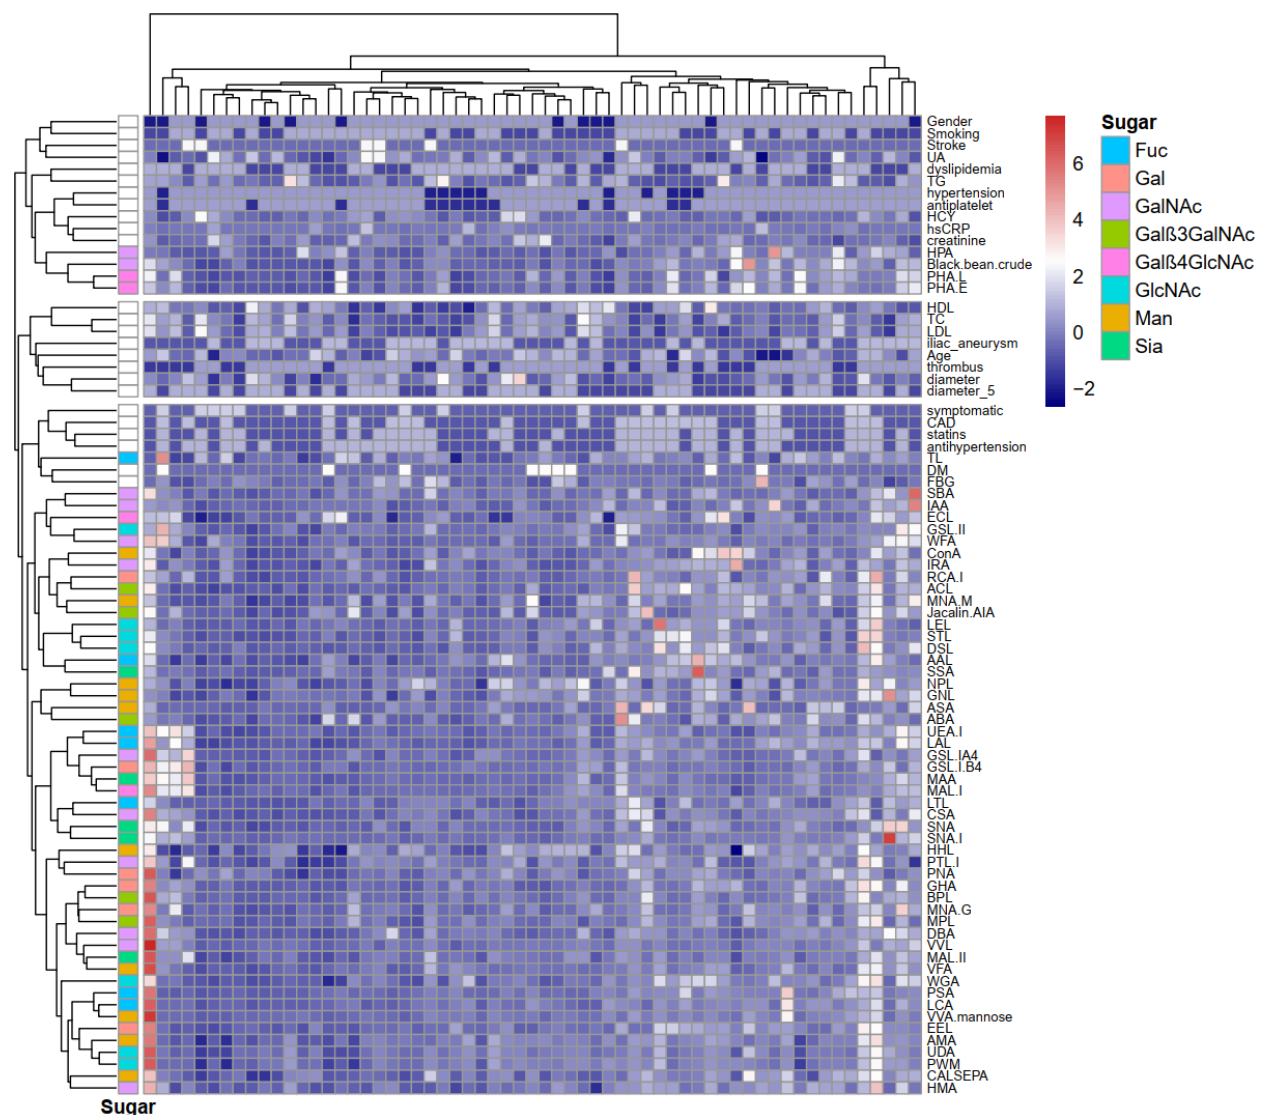
Figure 1. Heatmap of 56 lectin results from microarray analysis. Rows: samples; columns: lectins and clinical indicators. Preferred binding sugars for lectins were listed for each lectin. Color key indicates standardized fluorescent intensity for lectins, blue: lowest; red: highest. The heatmap was generated using R software (Version 4.0.2, https://cran.r-project.org/bin/windows/base/old/4.0.2/, accessed on 3 July 2021).